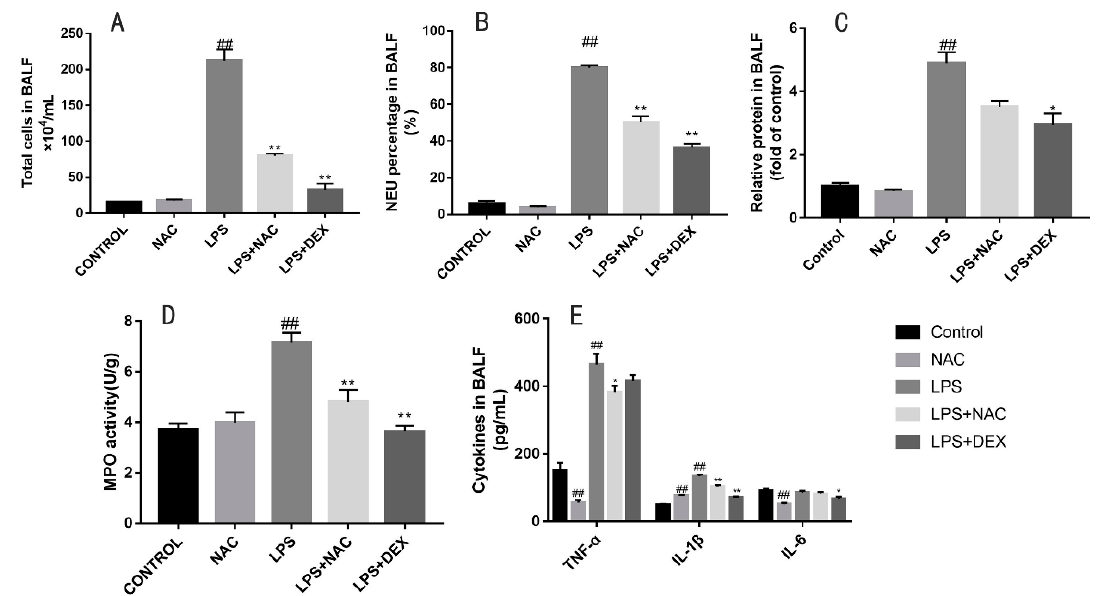
Figure 5. Protective effects of NAC treatment against LPS ‐ induced ALI mice. BALF was collected 12 h after LPS challenge to measure ( A ) total cells, ( B ) neutrophil percentage, ( C ) amount of protein, and ( E ) level of cytokines secretion. MPO activity in lung tissues ( D ) was measured at 12 h after intratracheal injection. All results are expressed as the means ± SEM (n = 6 in each group). ## indicates p < 0.01 compared with the control group, and ** indicates p < 0.01, * indicates p < 0.05 compared with the LPS group.